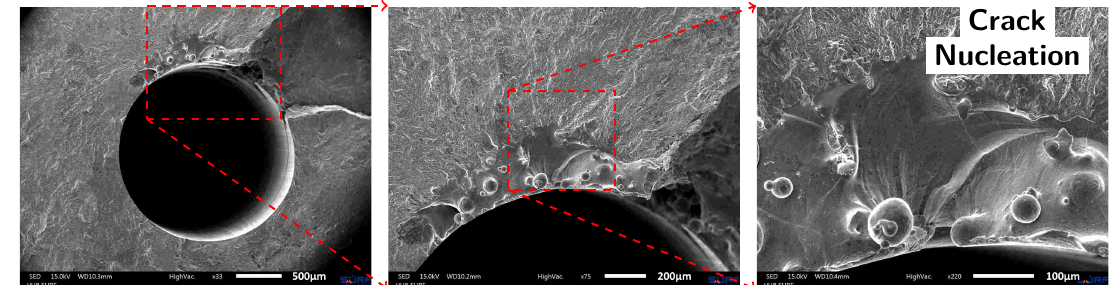
Figure 10. SEM images of the fracture surface of Specimen 13 (AM material with printed capillary after drilling operation). The drilling operation did not sufficiently remove the surface roughness of the printed capillaries and therefore did not solve the initiation issue around the